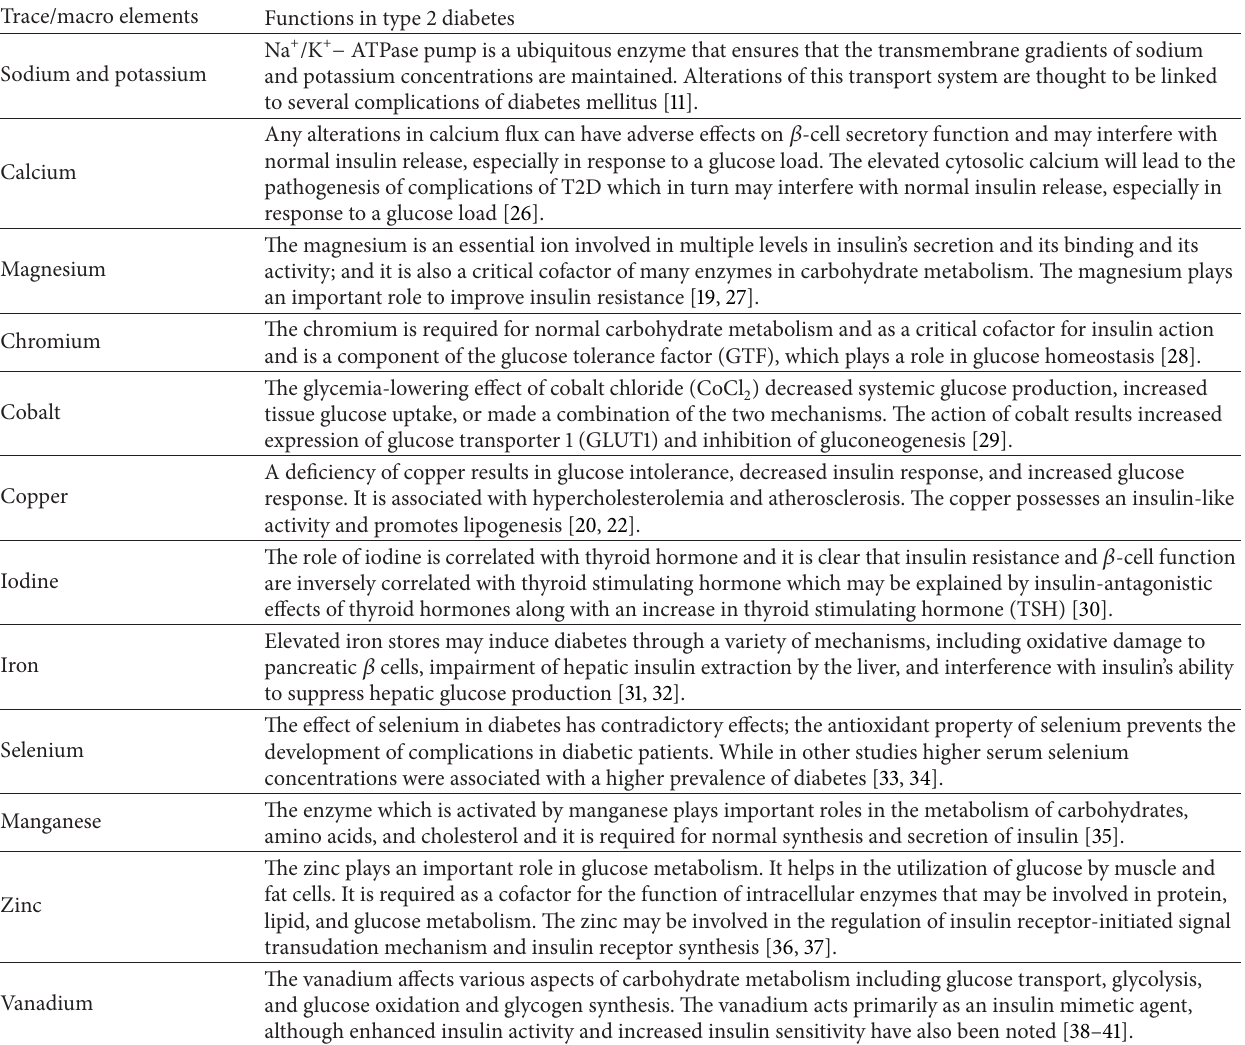
Table 2: Micronutrient functions in type 2